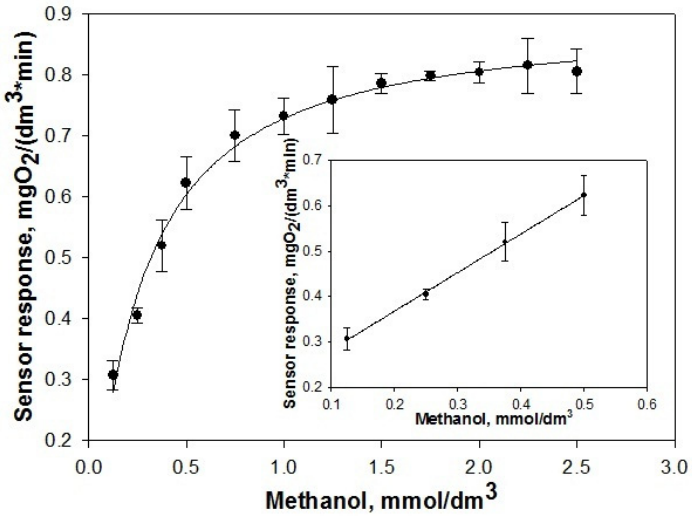
Figure 7. The calibration curve with the standard deviation of the biosensors (n = 7).